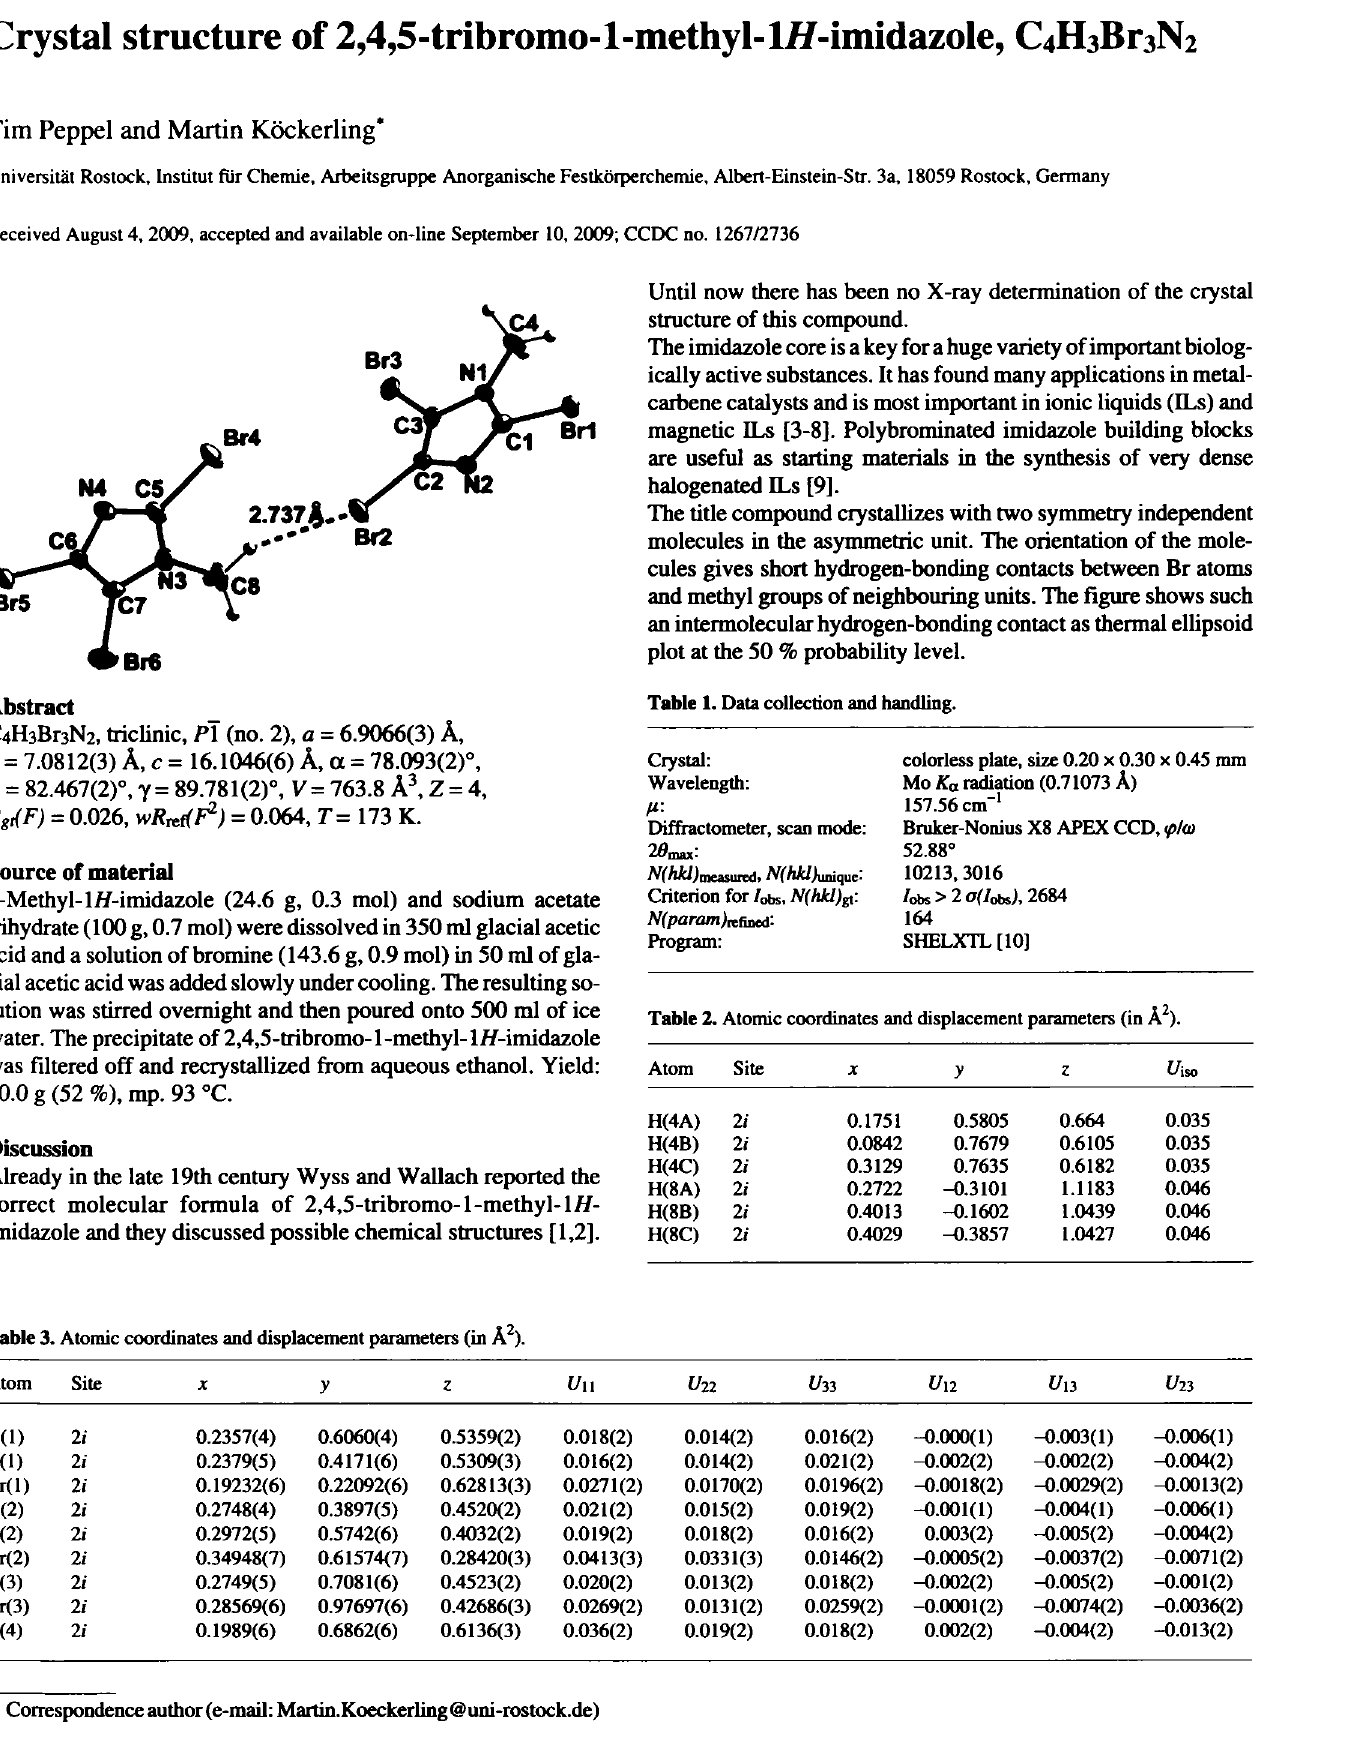
Table 3. Atomic coordinates and displacement parameters (in Â 2